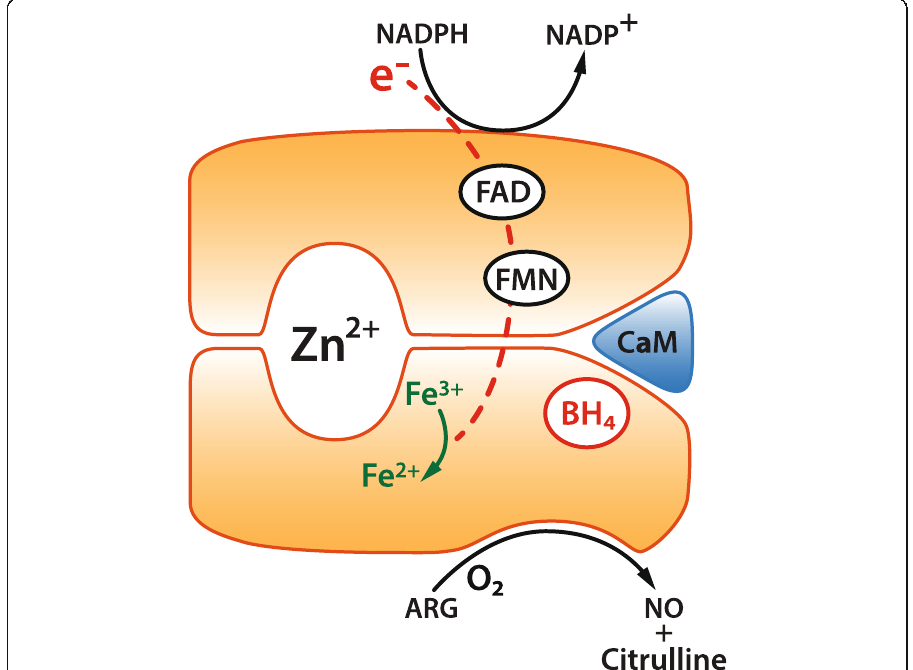
Fig. 1 Nitric oxide synthase (NOS) cofactors and activity. NOS enzymes function as homodimers within subunits structurally supported by a Zinc ion (Zn 2+ ). Following sequestration of iron, the binding site for arginine is expressed. Electron transfer also depends on flavin mononucleotide (FMN) and flavin adenine dinucleotide (FAD) availability and the binding of calmodulin (CaM) which is calcium dependent for eNOS and nNOS and independent for iNOS. NADPH, oxygen and tetrahydrobiopterin (BH4) are essential cofactors for the synthesis of nitric